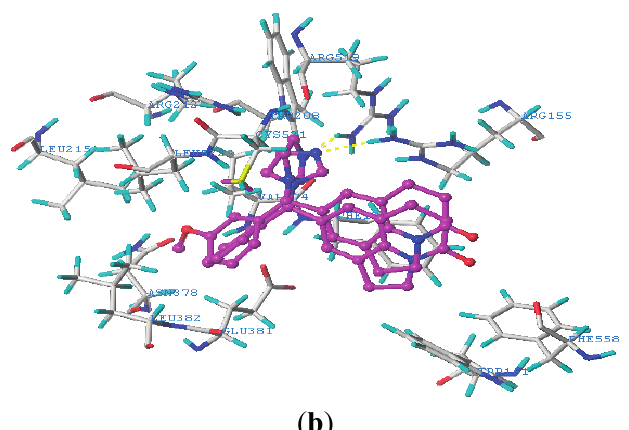
Figure 6. The Surflex-dock result. ( a ) The docking complex of compounds 33 , 37 with CYP11B1; ( b ) Binding mode of compounds 33 , 37 with